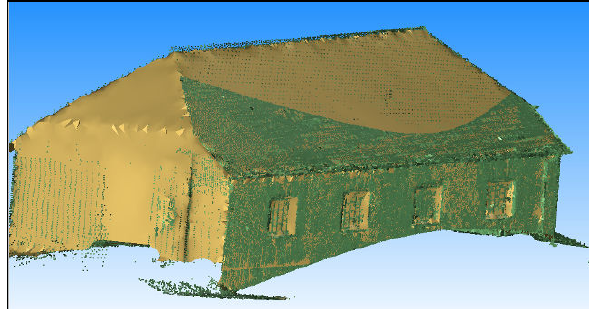
Figure 3 A comparison of mesh and original point data; yellow: mesh generated by 3D Reshaper, green: original point data